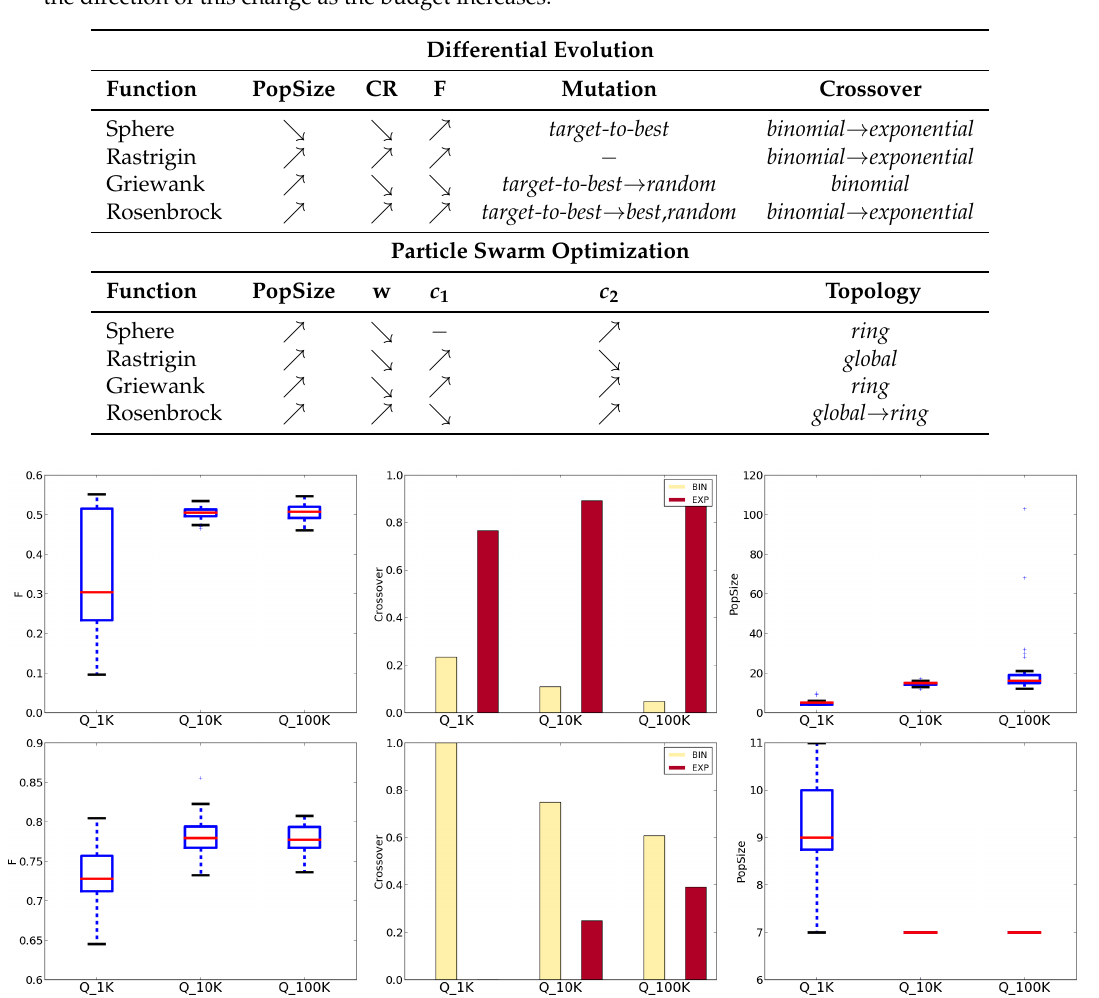
Figure 4. DE parameters of the top solutions (best 10%) for the 30-dimensional Rastrigin (first row) and Sphere (second row) functions, with an available budget of 1000, 10,000, and 100,000 fitness evaluations. Bar plots indicate the normalized selection frequency. Descending/ascending trends for all parameter values are clearly